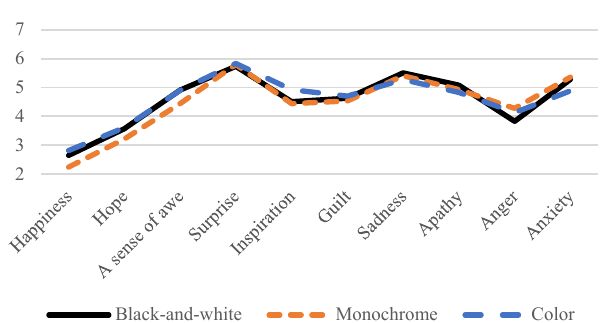
Figure 9. The line graph shows the average emotions of different colors in #4 image.